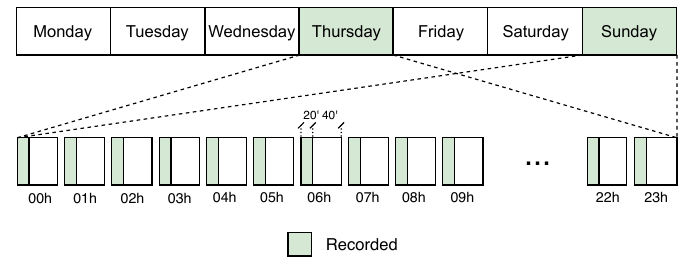
Figure 2. Diagram of the recording days and duration for each